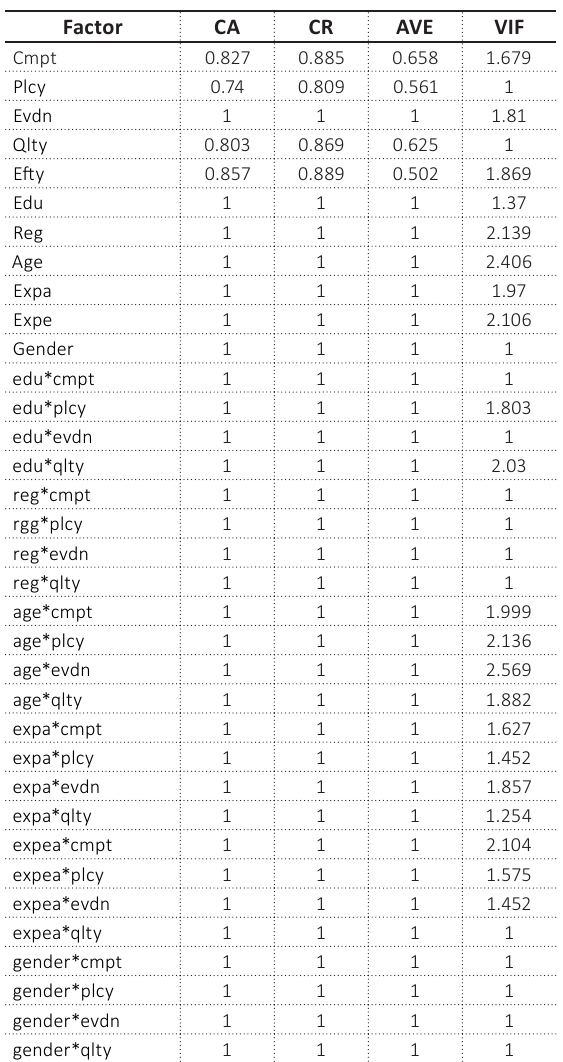
Table 3. Reliability, validity, and